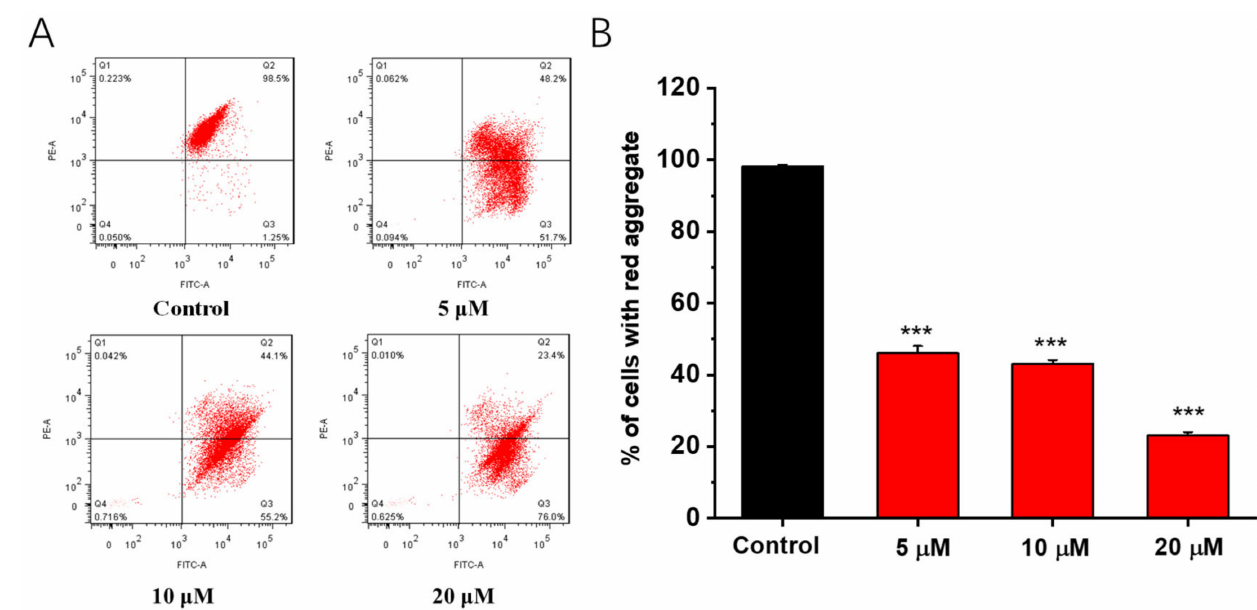
Figure 4. Effects of compound 1b on mitochondrial membrane potential ( ∆ ψ m ) in A549 cells. ( A ) Cells were treated with compound 1b at the tested concentrations for 48 h and stained with JC-1 dye. ∆ ψ m was analyzed via flow cytometry. ( B ) The quantification of % of cells with red aggregates. The values are presented as the means ± SD ( n = 3). *** p < 0.001 vs. control